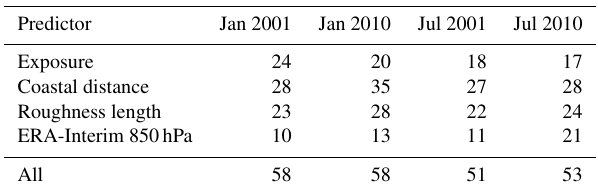
Table 2. Whole-domain averages of the spatial variance explained by single predictors (%) for monthly mean wind speed and 4 tested months. The bottom row shows the result for the multiple regression model involving all